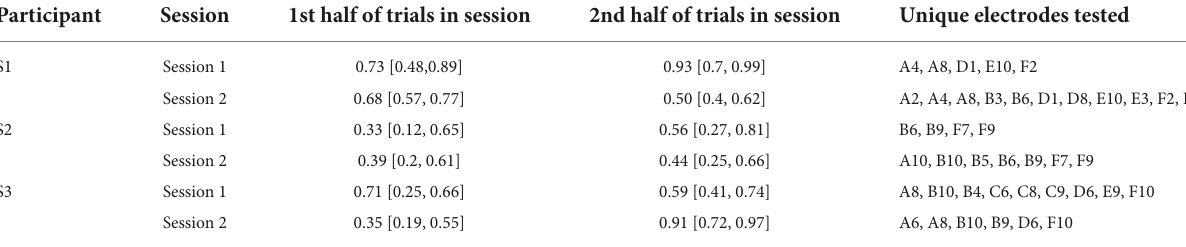
TABLE 5 Probability of reporting two percepts, within and across sessions.